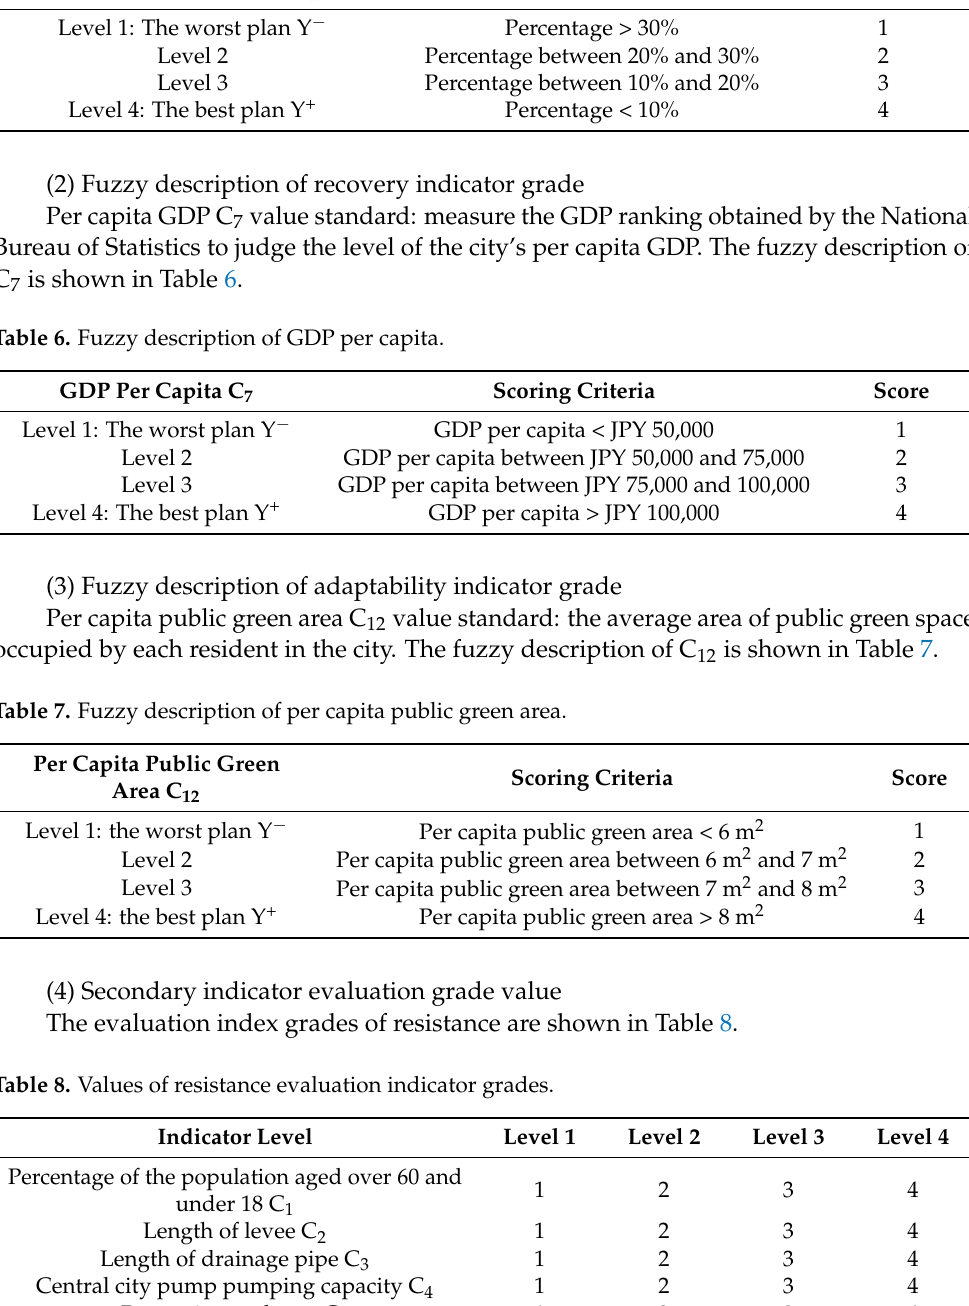
Percentage of the Population Aged Over 60 and Under 18 C 1